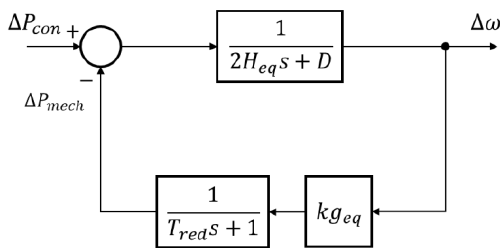
Figure 1. Reduced frequency response (RFR)